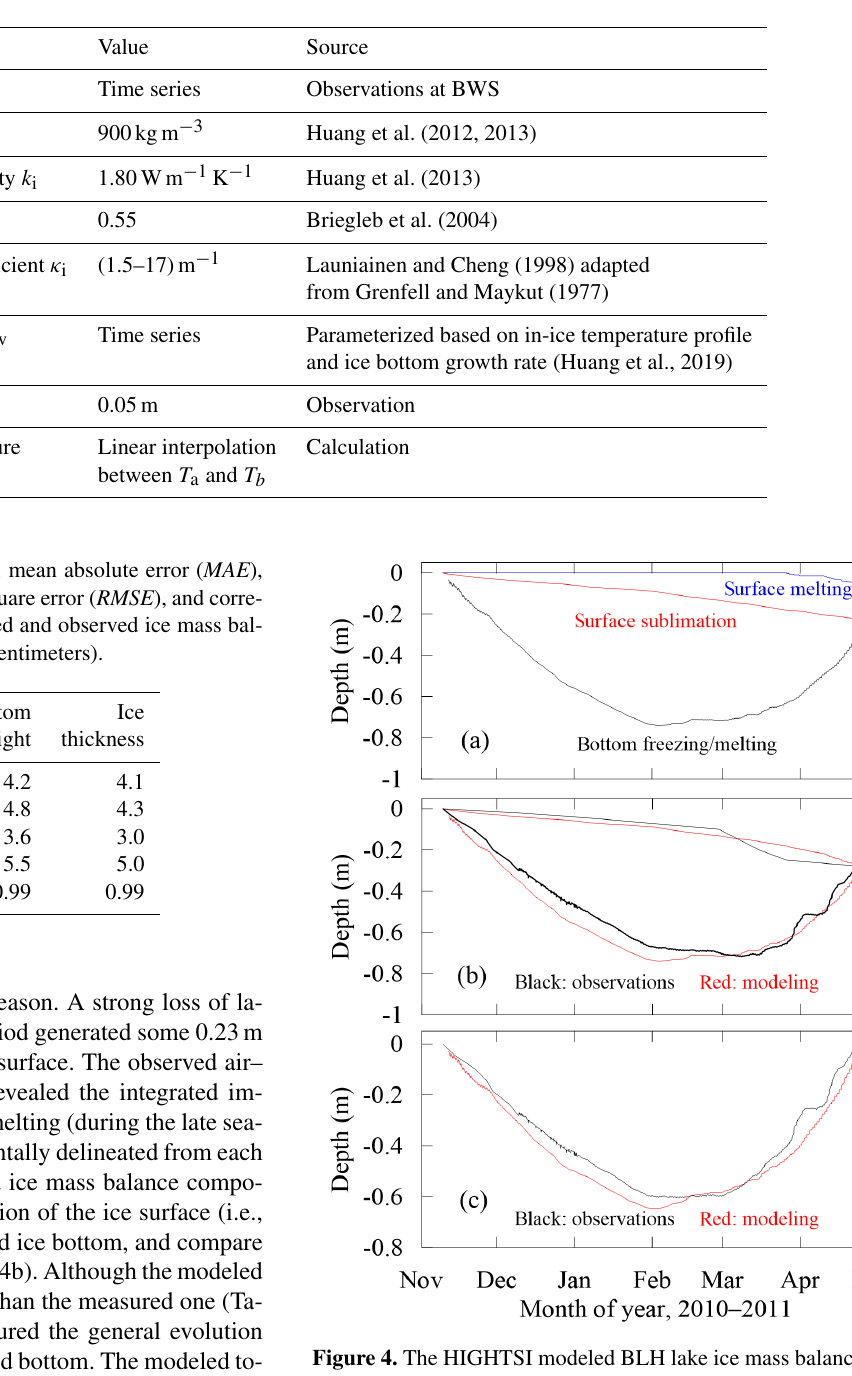
Table 1. Parameters and input data applied in the model reference run.